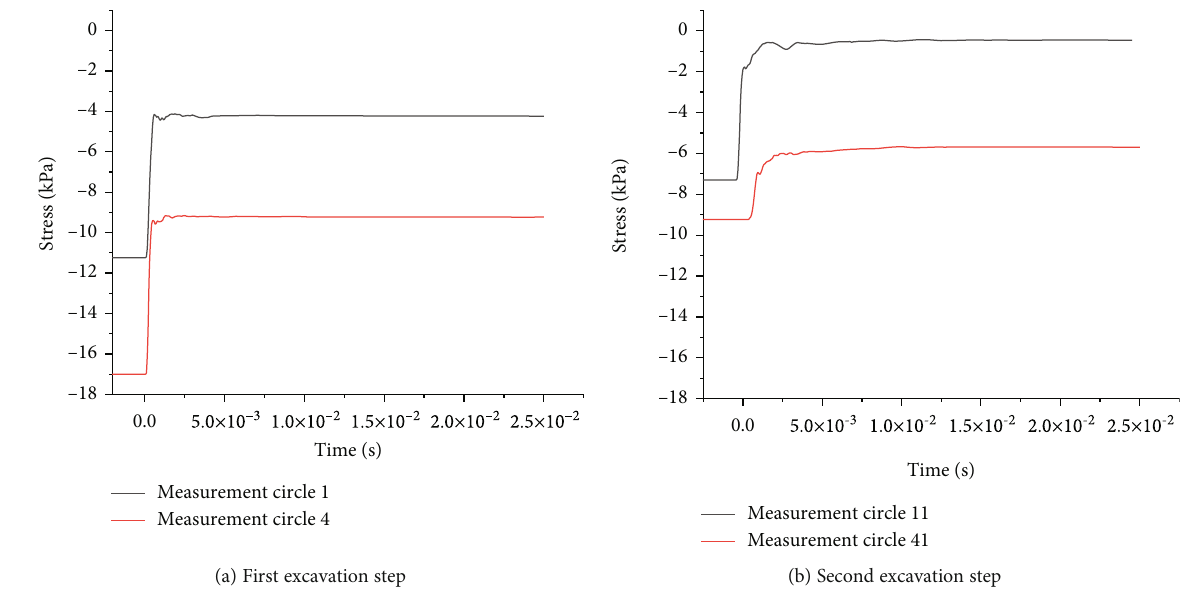
Figure 9: Stress evolution in the overlying strata at the upper right-hand corner of the roof and the lower left-hand corner of the fl oor after the fi rst excavation step (measurement circles 1 and 4, respectively) and after the second excavation step (measurement circles 11 and 41, respectively).